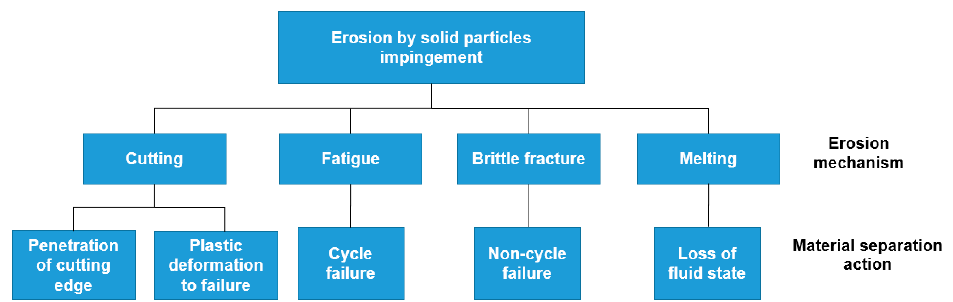
Figure 5. The mechanism of solid particles erosion (SPE). Reproduced with permission from [40]. Elsevier,